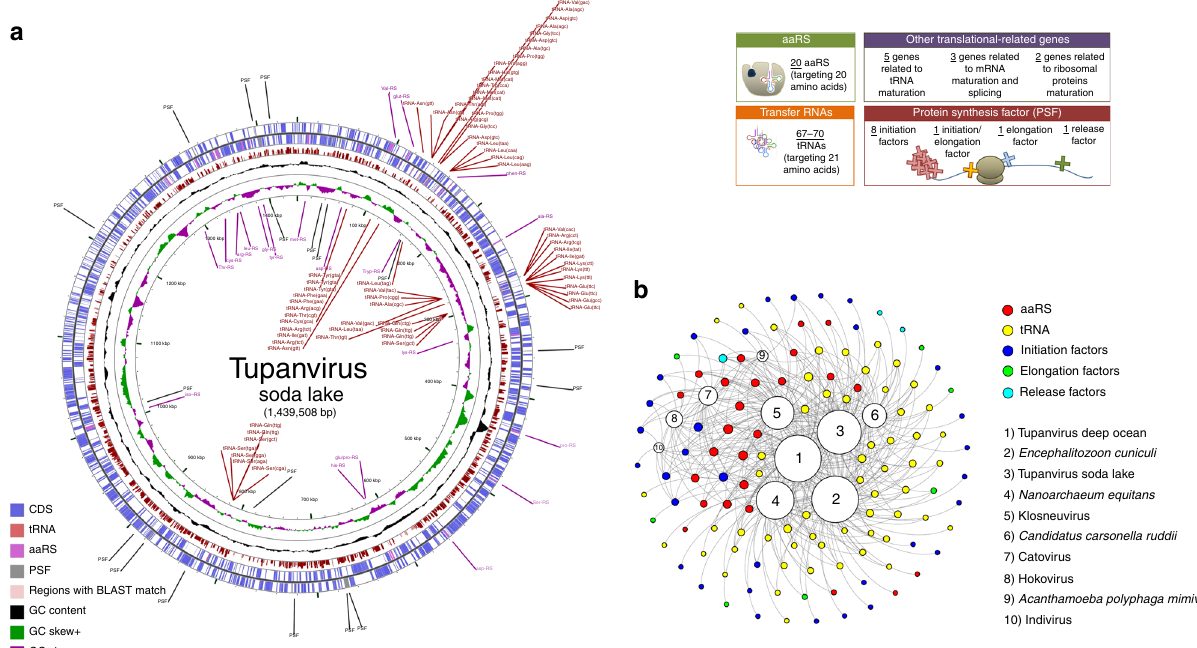
Fig. 5 Tupanvirus genome-translation-related factors. a Circular representation of Tupanvirus soda lake genome highlighting its translation-related factors (aaRS, tRNAs and PSF). The box (upright) summarizes this information and considers the Tupanvirus deep ocean data set. b Network of shared categories of translation-related genes (not considering ribosomal proteins) present in tupanviruses, Mimivirus (APMV), Klosneuvirus, Catovirus, Hokovirus, Indivirus and cellular world organism — Encephalitozoon cuniculi ( Eukaryota ), Nanoarchaeum equitans ( Archaea ) and Candidatus Carsonella ruddii ( Bacteria ). The diameter of the organism ’ s circles (numbers) is proportional to the number of translation-related genes present in those genomes. CDS coding sequences, tRNA transfer RNA, aaRS aminoacyl tRNA synthetase, PSF protein synthesis